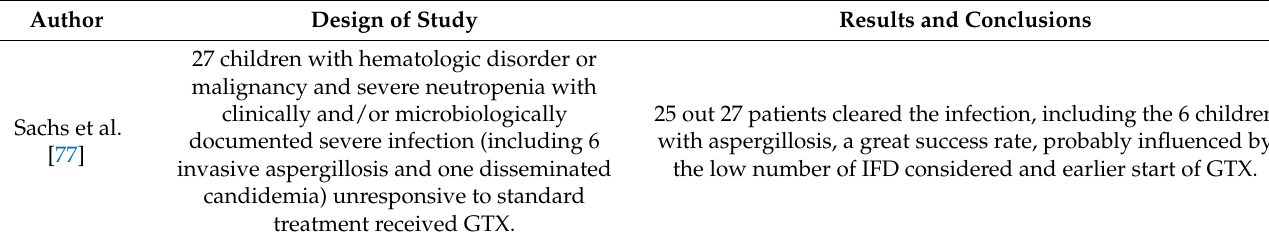
Table 3. Main studies on the use of granulocyte transfusion in pediatric